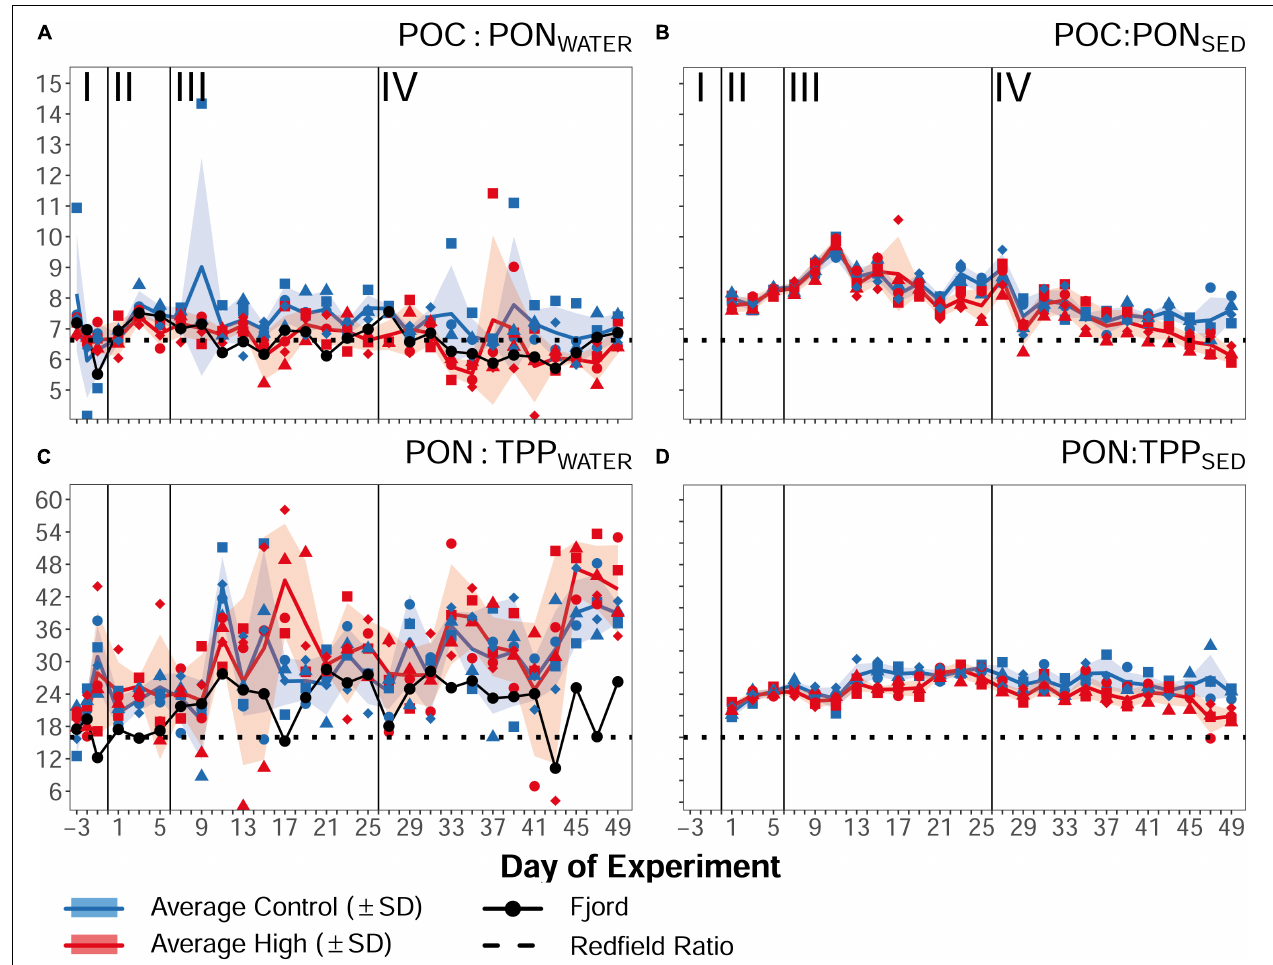
FIGURE 9 | Organic matter ratios of (A) particulate organic carbon and nitrogen in the water column, (B) the respective flux to the sediment trap, (C) particulate organic nitrogen and particulate phosphorous in the water column, and (D) the respective flux to the sediment trap over the course of the experiment. Lines, symbols, and colors are used as described in Figure 4 . Roman numerals label the different phases of the experiment separated by vertical lines (for description of phases see Table 2 ). Figure created with the ggplot2 package in RStudio (Rstudio Team, 2016; Wickham et al.,